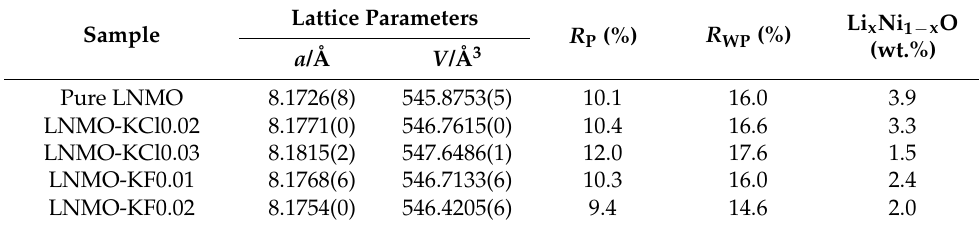
Figure 1. XRD patterns of all samples compared with the standard LNMO pattern ( a ); Enlarged region of 30–50 degrees for all samples ( b ). Table 1. Lattice parameters of all